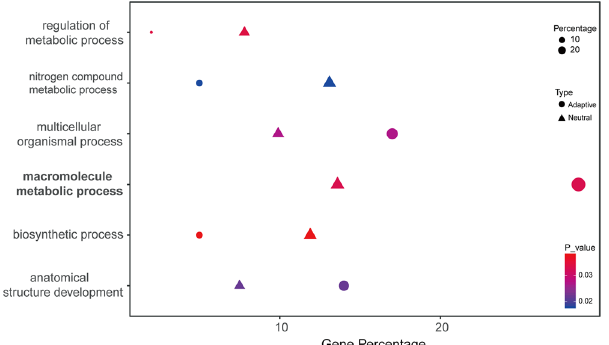
Figure 4. The significant enrichment GO terms for genes with adaptive SNPs and genes with neutral SNPs obtained with WEGO. The Bold GO term is detected between all tributaries and MS, the other GO terms are detected between up-tributaries and low-tributary.